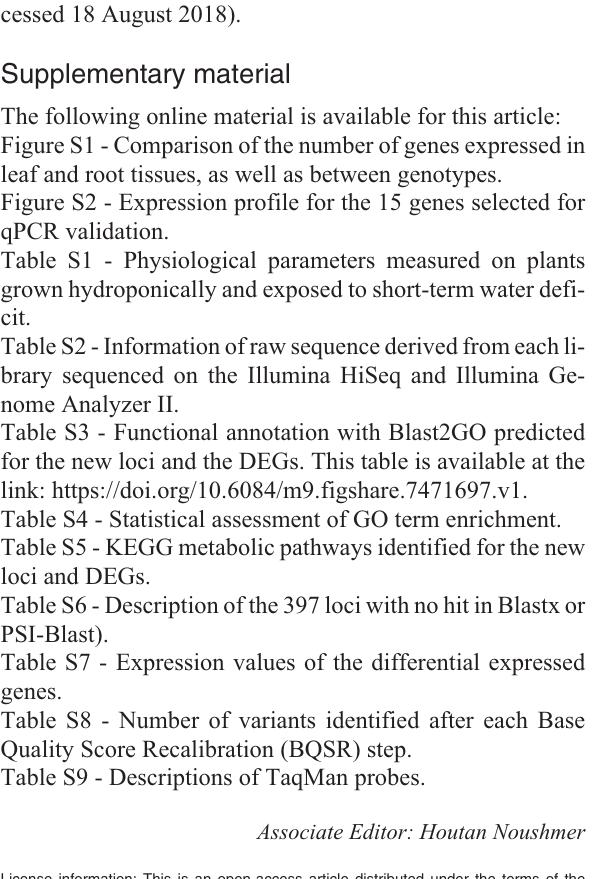
Figure S1 - Comparison of the number of genes expressed in leaf and root tissues, as well as between genotypes. Figure S2 - Expression profile for the 15 genes selected for qPCR validation. Table S1 - Physiological parameters measured on plants grown hydroponically and exposed to short-term water defi- cit. Table S2 - Information of raw sequence derived from each li-